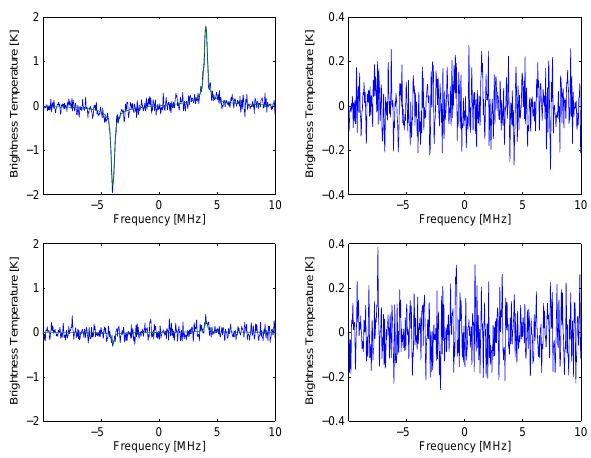
Fig. 1. Block diagram of the 115GHz CO receiver system. The cold load is regularly mounted and used. Since the hot-cold calibrations are performed ahead of the lens, the losses in the lens and in the other components (horn, mixer, etc) along the transmission line are corrected for. Table 1. Receiver specifications.